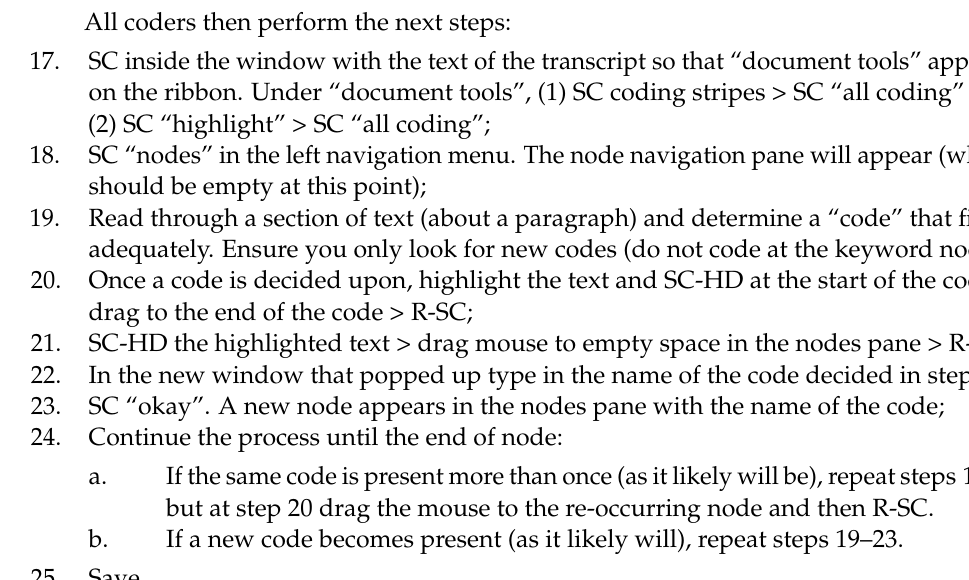
Table 1. Decisions around limiting the amount of data open coded.